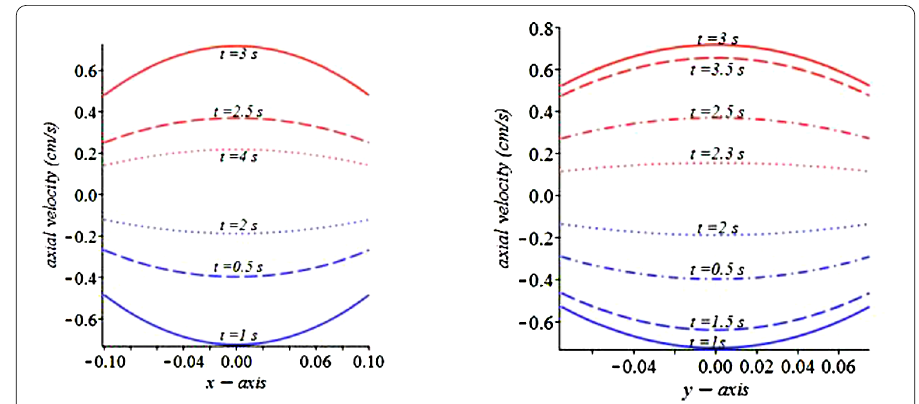
Figure 2 Oscillating flow of fluid. Axial velocity in the 1st full wave cycle for a = 0.1 cm, b = 0.075 cm and slip length of 0.01